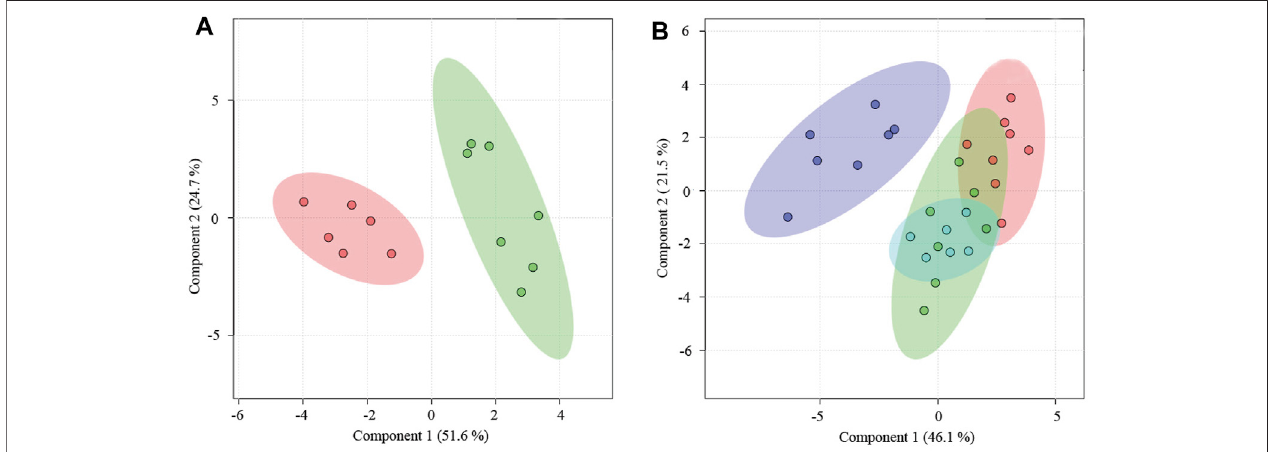
FIGURE 7 | A combination treatment for PMS. (A) PLS-DA analysis of metabolomics for the plasmas of PMS rats treated with (red) and without Zuogui-CSS (green). (B) Metabolomic pro fi les of the plasmas of PMS rats treated with Zuogui-CSS (blue), PMS rats (purple), perimenopausal rats (green), and rats of 6 months old (red).